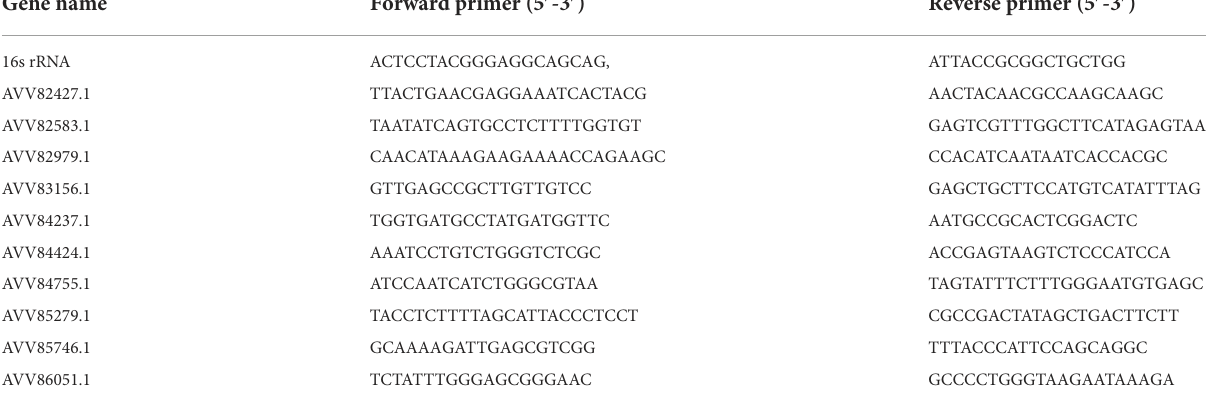
TABLE 1 Primer sequences of the quantitative real-time PCR